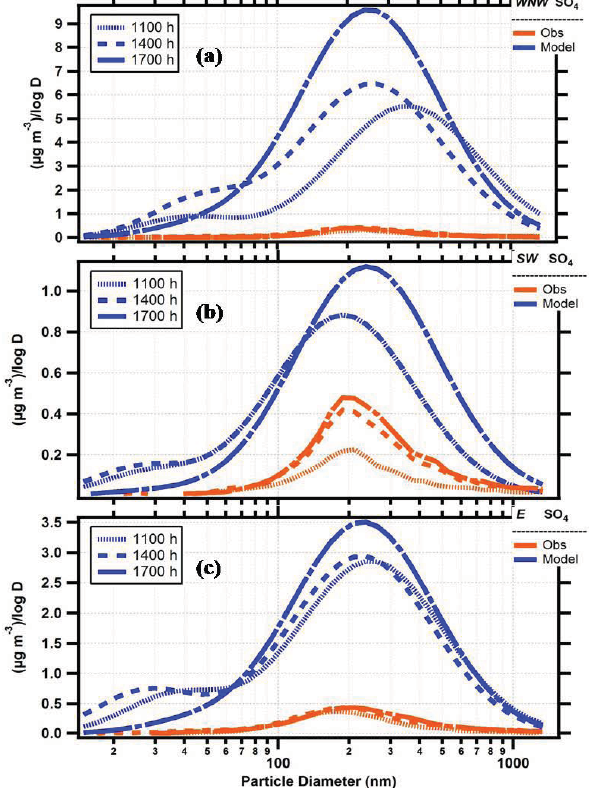
Figure 6. The average mass concentrations of sulfate as a function of size, simulated by the Figure 7. The size distributions are for the same conditions described in Fig. 6, but for model (blue lines) and measured with the AMS (orange lines), are compared for Fig. 6. The average mass concentrations of sulfate as a function of nitrate. Fig. 7. The size distributions are for the same conditions described three time periods when air originates from (a) the WNW, (b) SW and (c) E. size, simulated by the model (blue lines) and measured with the in Fig. 5, but for AMS (green lines), are compared for three time periods when air originates from (a) the WNW, (b) SW and (c) E.